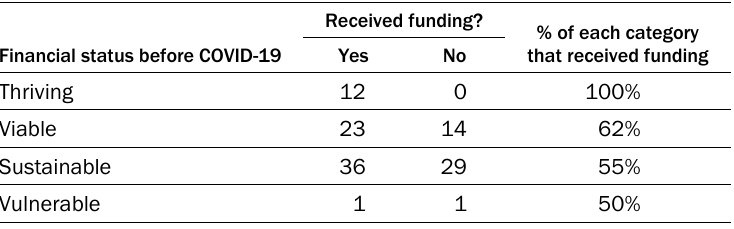
Table 8. Financial Status Before COVID-19 by Whether